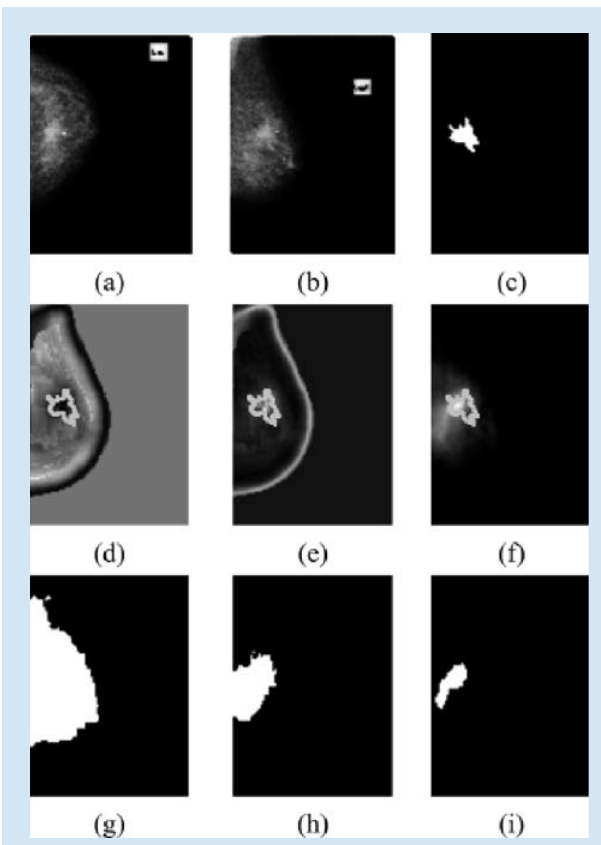
Fig. 4. Sample images: (a) reference image, (b) search image, (c) ground- truth map, (d) distance map, (e) TM similarity map, (f) MI similarity map (g - i) MI similarity map thresholded at grey levels of 1, 64 and 128. The thresholded maps are compared with the ground-truth map in (c) to determine the TPF- and FPF-values that were used to generate an ROC curve.